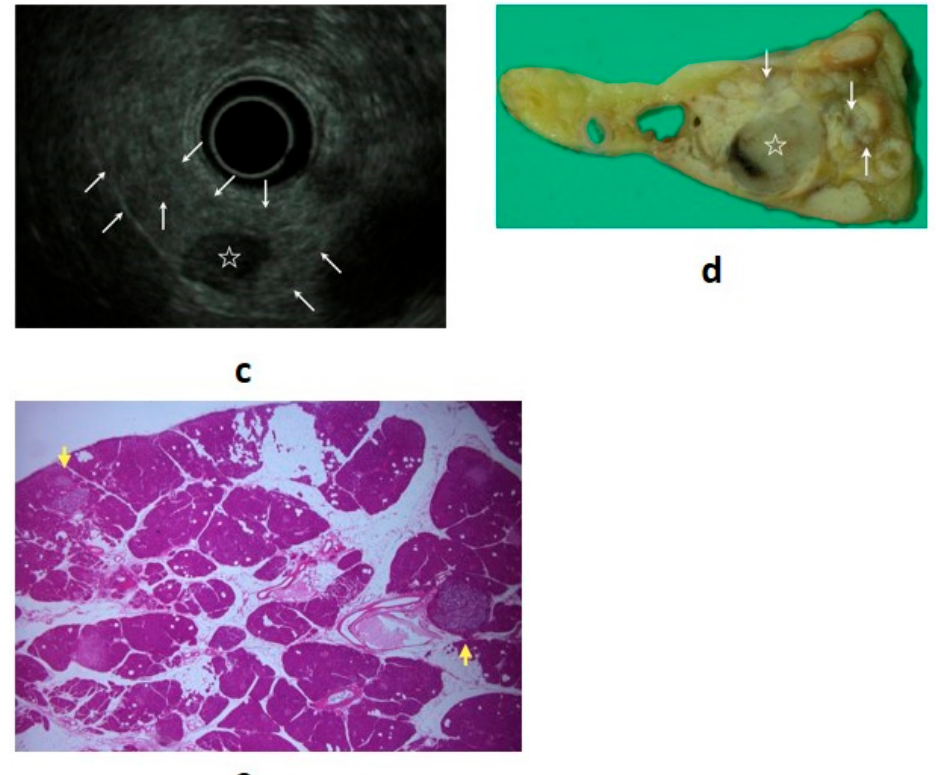
Figure 2. ( a ) Contrast-enhanced computed tomography (CT): a mass lesion with early hyperen- hancement is seen in the tail of the pancreas (red arrow), but there are no other obvious lesions. ( b ) Diffusion-weighted magnetic resonance imaging (MRI): the mass in the pancreatic tail shows re- duced diffusion. ( c ) Endoscopic ultrasound (EUS): in addition to the mass ( ☆ ) revealed by CT/MRI, many small hypoechoic masses are observed (white arrow). ( d,e ) Resected specimen: the main lesion ( ☆ ) is an 11 mm neuroendocrine neoplasm (NEN) G1, but multiple tumors with diam- eters of 1–3 mm are observed in the surrounding pancreas (white and yellow arrow) (20×). They are multiple NENs associated with multiple endocrine neoplasia type 1 (MEN-1).